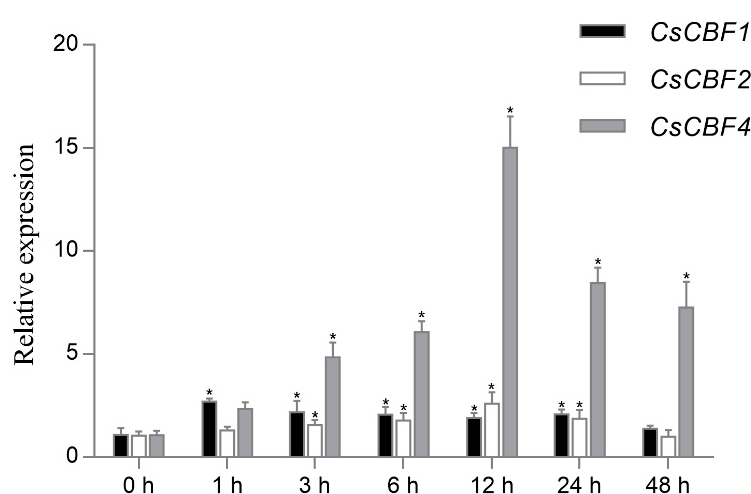
Figure 4. Expression of CsCBF genes under 4 °C treatment. The transcripts were analyzed by qRT-PCR. Error bars indicate the standard error of the mean ( n = 3). Asterisks indicate statistically significant differences ( p < 0.05). CsGAPDH was used as an internal control. The expression value is listed in Table S4.